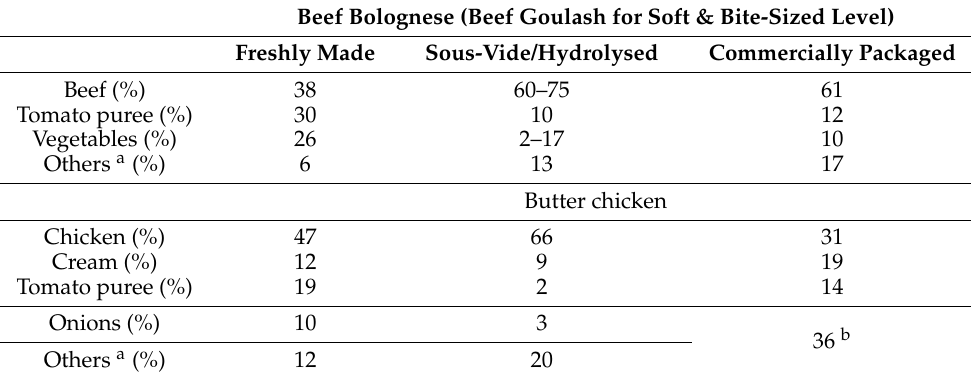
Table 1. Ingredient composition in sample texture-modified meals used in the focus group. Beef Bolognese (Beef Goulash for Soft & Bite-Sized Level) Freshly Made Sous-Vide/Hydrolysed